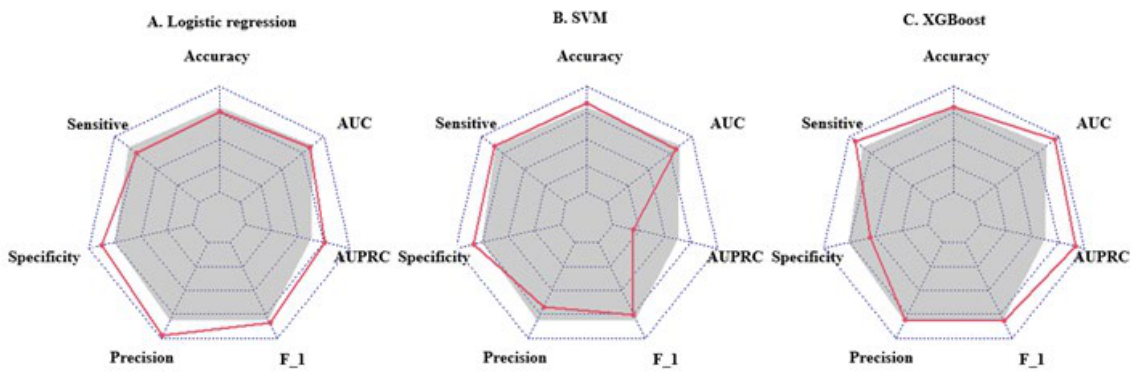
Figure 3. Radar plot of evaluation metrics for machine learning prediction models. The axes starting from the same starting point indicate multiple evaluation metrics with a starting point of 0 and an end point of 1. The points on the corresponding axes of the evaluation metrics indicate the size of the metric, and the grey shading corresponds to the mean value of the three models. F_1 = F1 score; AUC = area under receiver operating characteristic curve; AUPRC = area under the precision-recall curve.